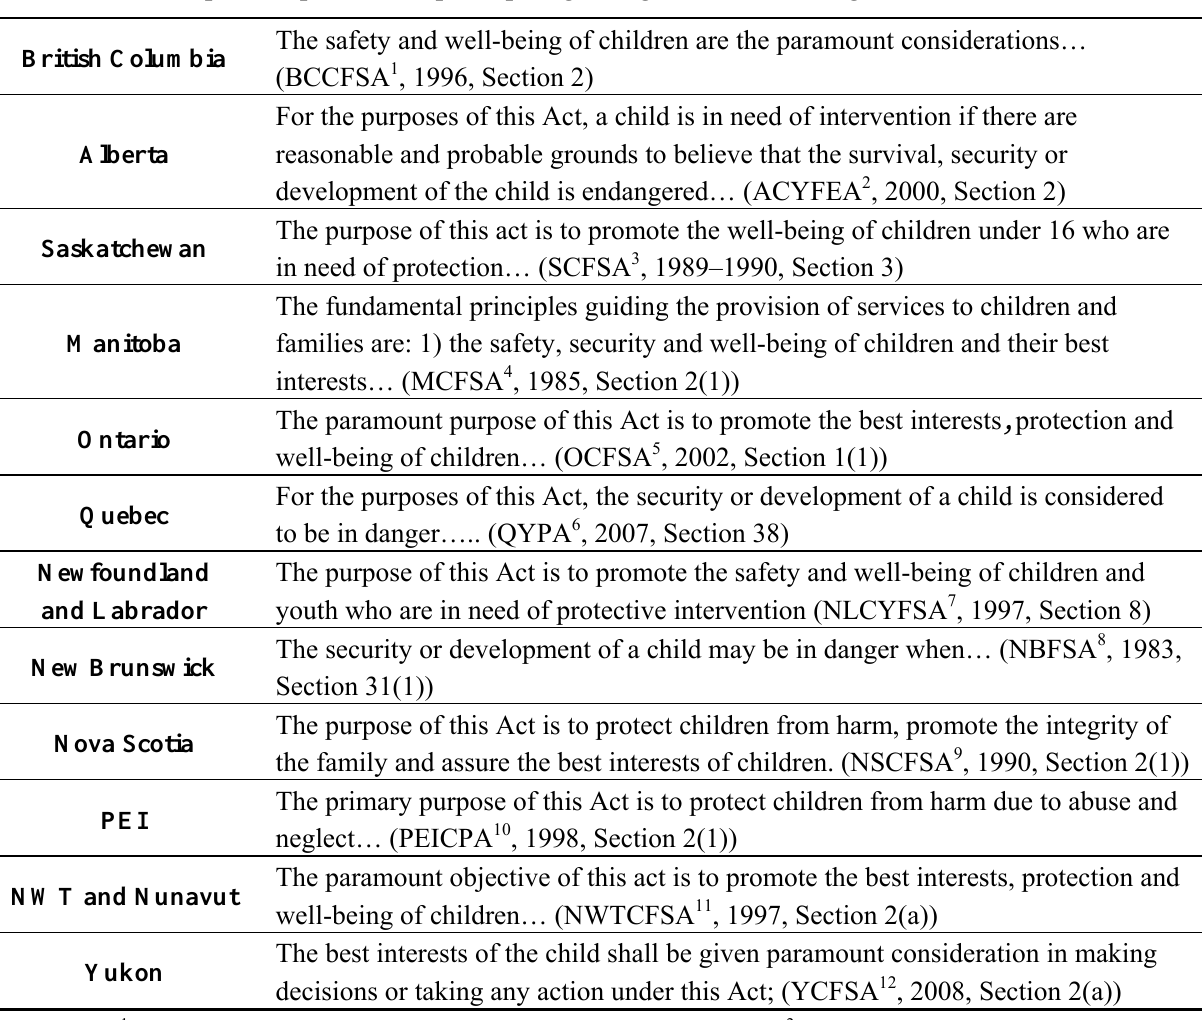
Table 1. Purpose or paramount principles guiding child welfare legislation across